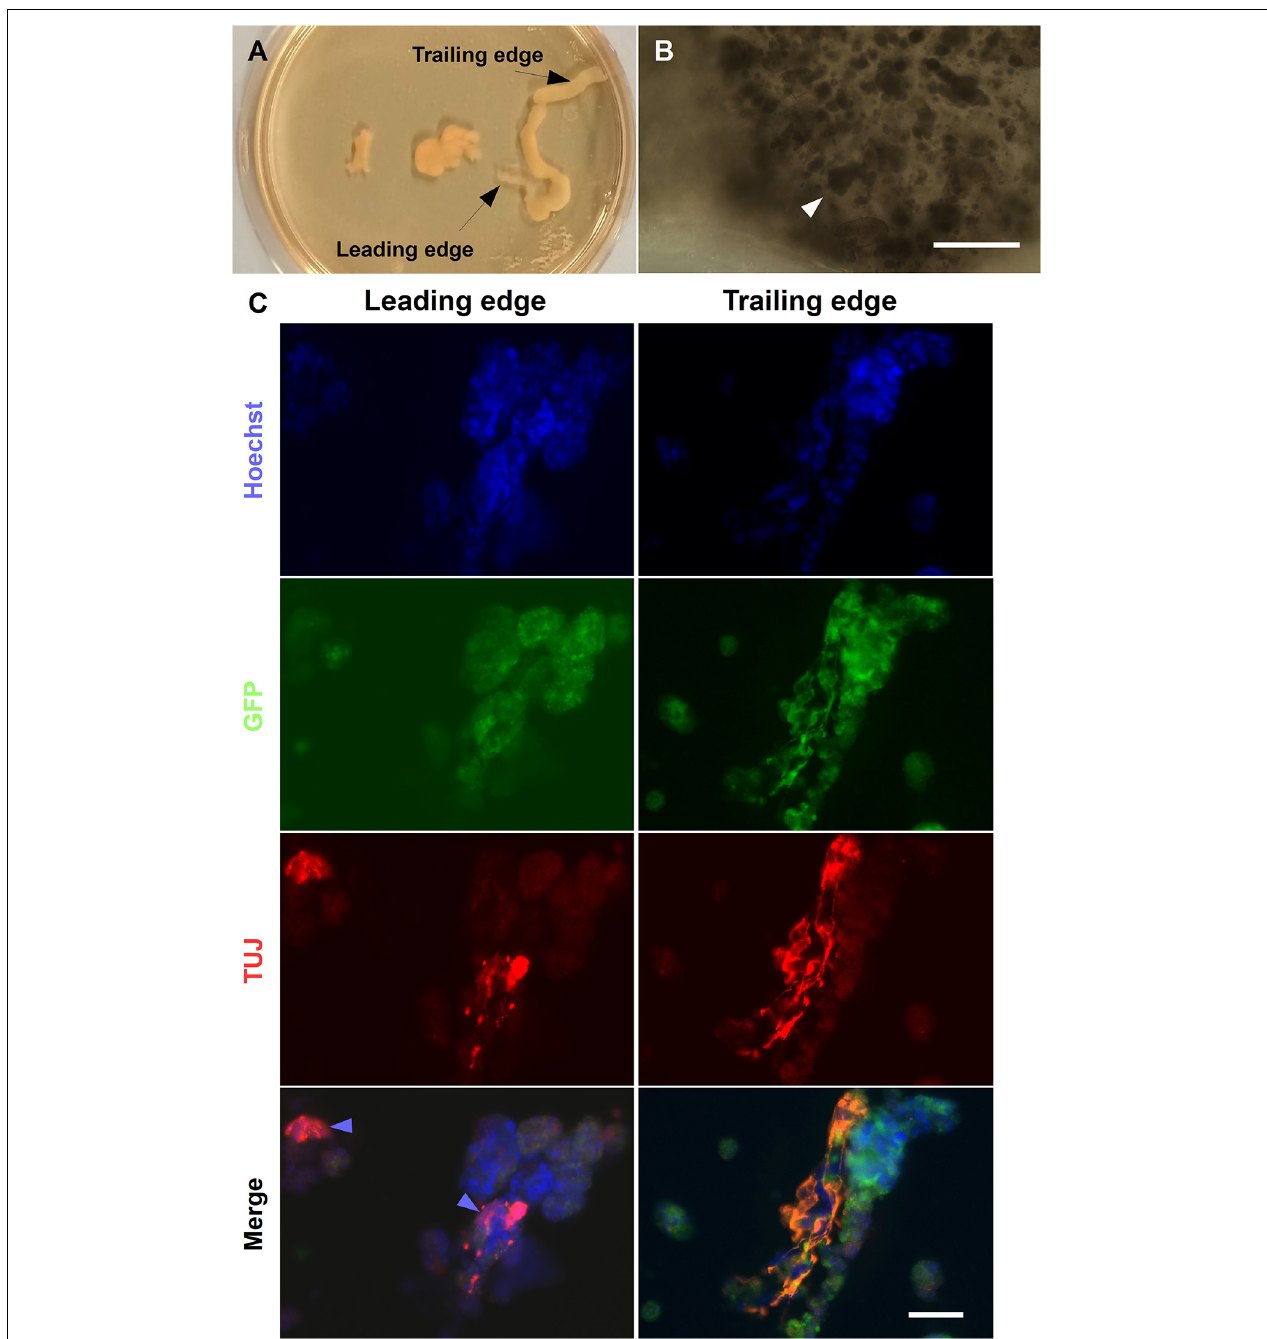
FIGURE 10 | Neural differentiation in alginate tubular scaffold co-cultures. (A) Brightfield images of alginate fibers formed using a gradient maker. (B) High magnification images of the leading sections of a fiber on day 6 showing encapsulated aggregates (white arrowheads). Scale Bar: 400 µ m. (C) Alginate fibers contained ectoderm marker β III-tubulin. The fibers contained TUJ1 + cells at both the ends by day 6 of differentiation. However, TUJ + /GFP − cells can be seen predominantly at the leading end of the fiber, where most MNs are localized (blue arrowhead). Scale Bars: Top right panel: 400 µ m, bottom right panel: 50 µ